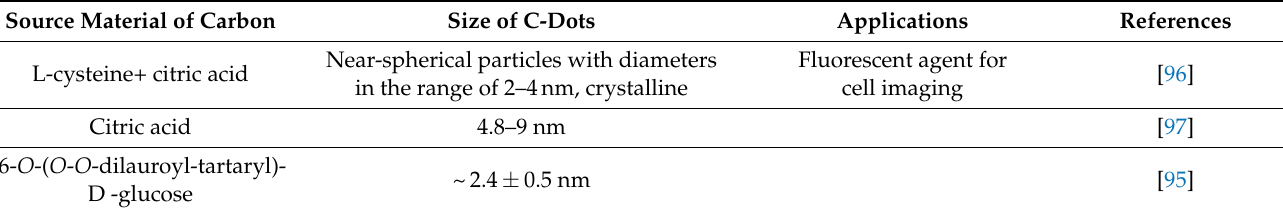
Table 6. Carbonization-based methods for synthesis of